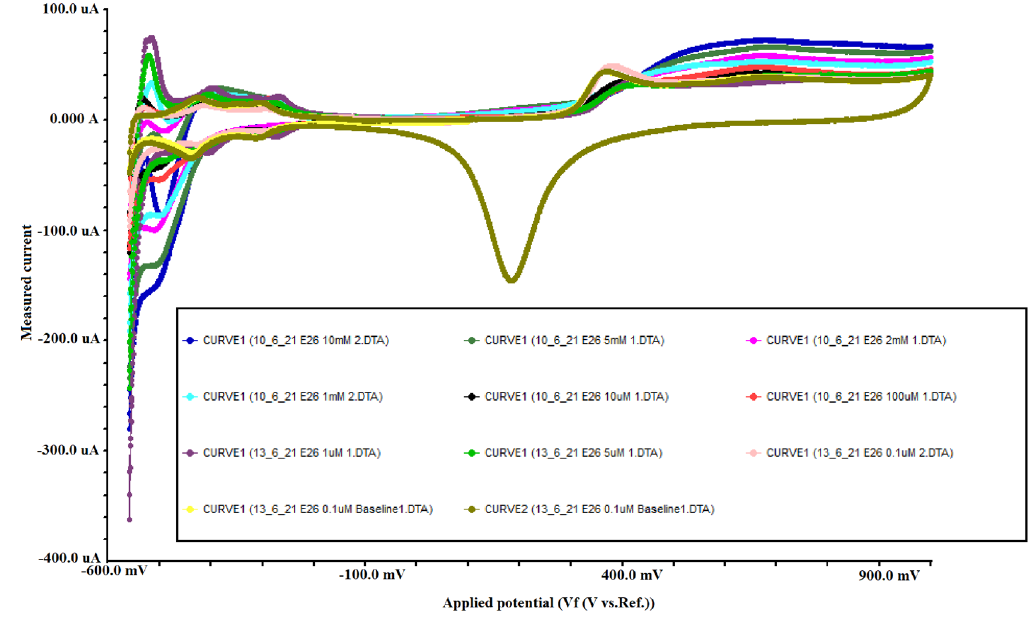
Figure 4. Cyclic voltammetry results for a range of (0–10 mM).